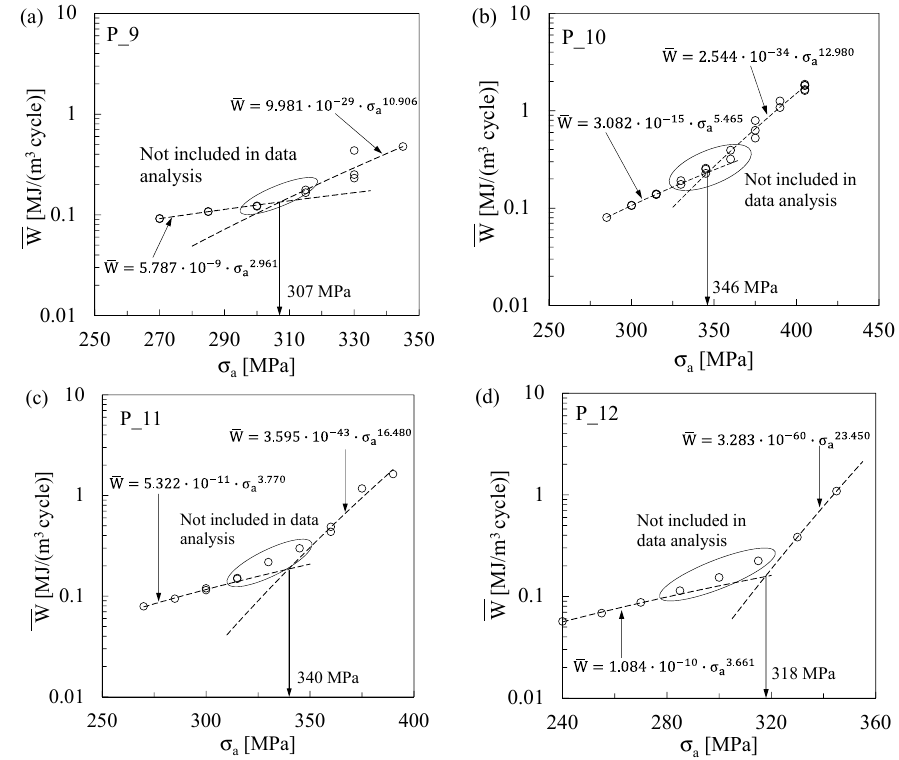
Figure 17. Step-load fatigue tests reanalyzed in terms of W for ( a ) P_9, ( b ) P_10, ( c ) P_11 and ( d ) P_12 specimens.